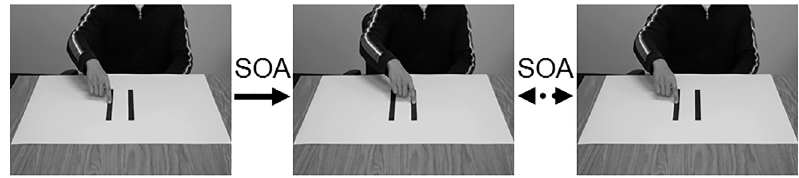
Figure 1. Right/Left images and sequence of events used for the apparent motion stimuli during the action perception task. The first arrow indicates that the first image was of the model with their finger on the right target and that it was followed by the image with model’s finger on the left target presented after the specific SOA for that trial. The two-way arrow indicates that the images were alternately presented until the the enter key was